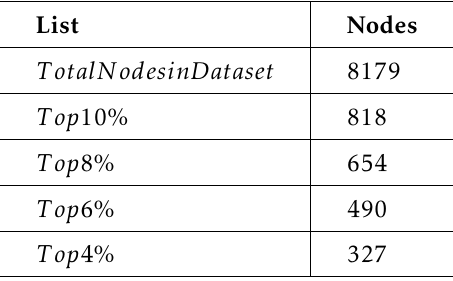
Table 1. Lists of Nodes After Applying Centrality Measures (i.e., Degree, Betweeness, Closeness and